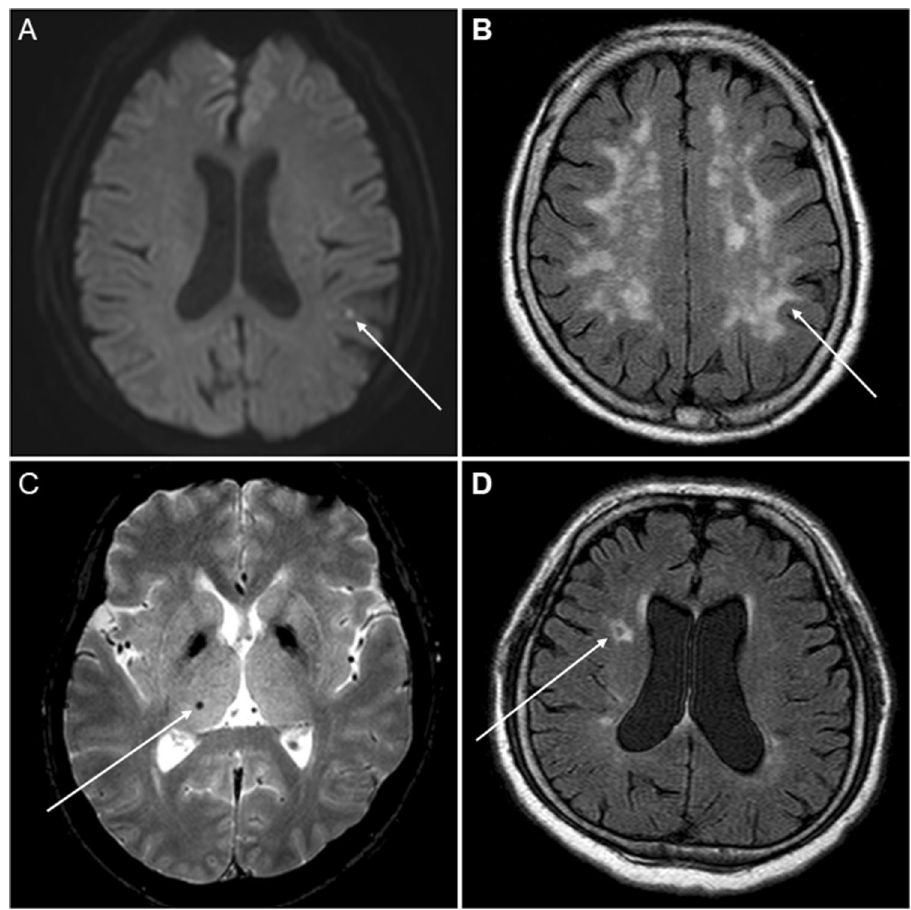
Figure 1. Representative cerebral magnetic resonance imaging of ( A ). acute infarction, ( B ). white matter hyperintensity lesion, ( C ). cerebral microbleeds, and ( D ). silent lacunar infarction. Arrows indicate the corresponding lesion in each